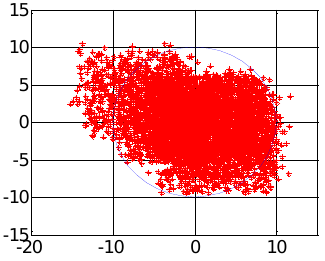
Figure 14. The ASFs of the AIS received signal correcting the positioning error.